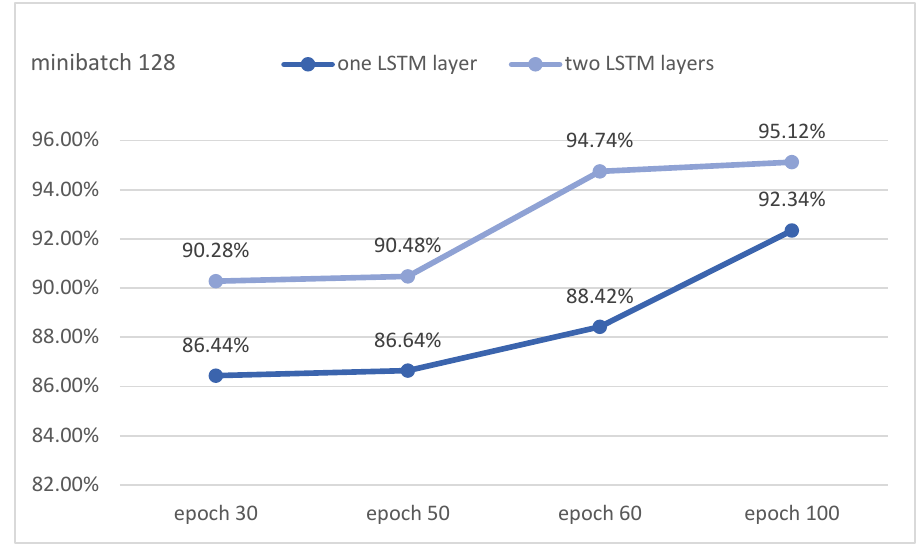
Figure 19. Accuracy of LSTM-based personal identification.